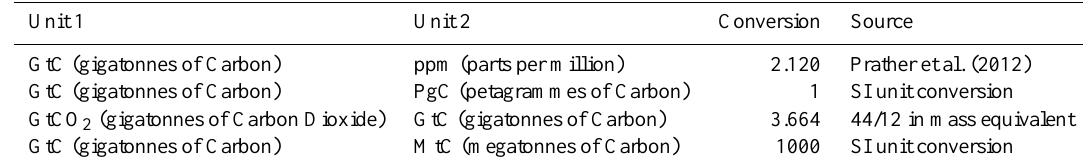
Table 1. Factors used to convert carbon in various units (by convention, Unit 1 = Unit 2 ·